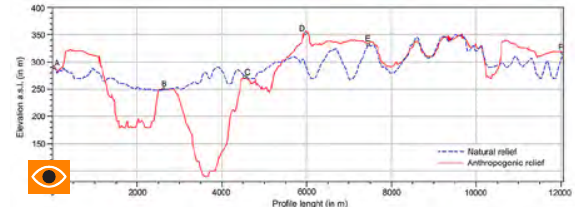
Figure 2. Cross-profile (A-B-C-D-E-F) in a section of hypsometric map of the study area